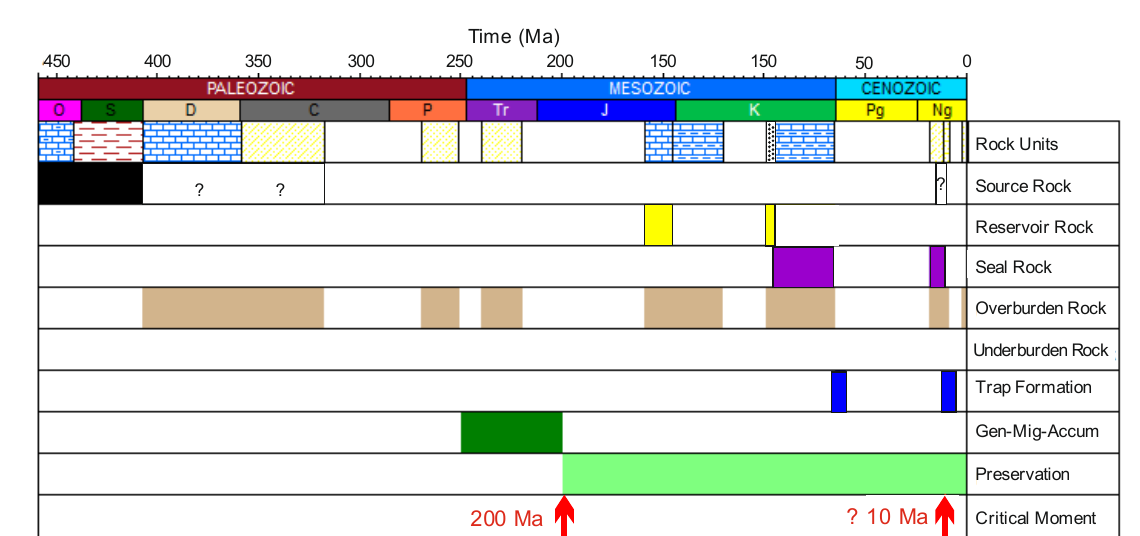
Figure 10. Petroleum system chart for study area. Sedimentary succession is not complete because it is divided by several significant unconformities. They likely represent periods of erosion of formerly deposited sediments. As a result, the burial history is not clear, and it is difficult to establish the timing of petroleum system events. Source rocks in the Pilzno-40 are Ordovician and Silurian strata; however, in adjacent areas, Devonian and Lower Carboniferous strata also include source rocks horizons. In the Outer Carpathians, Oligocene Menilite Shales are proven source rocks. In source rocks box the sign “?”means possible source rocks horizons. In Critical Moment box the sign “?”means the second possible critical moment due to hydrocarbon generation in the Oligocene Menilite Shales (ca. 10 Ma).